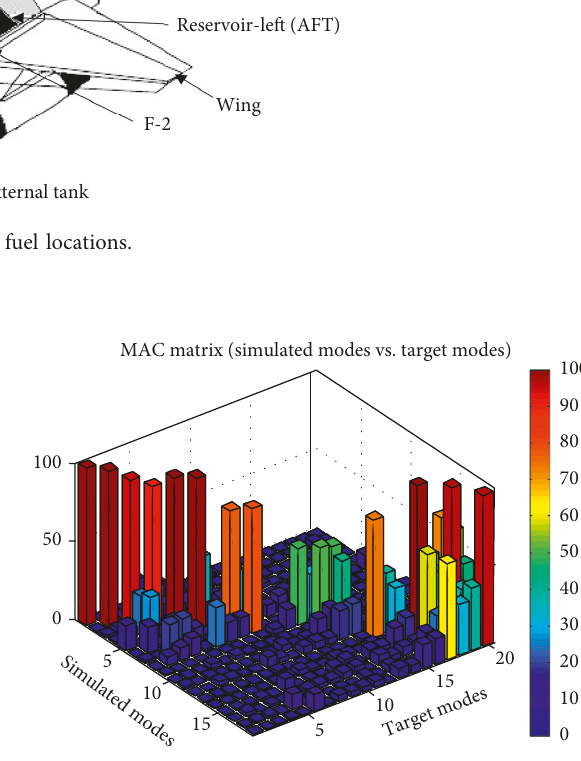
Figure 32: MAC of configuration 1 simulated-target model. Table 18: Fuel configurations for configuration 1